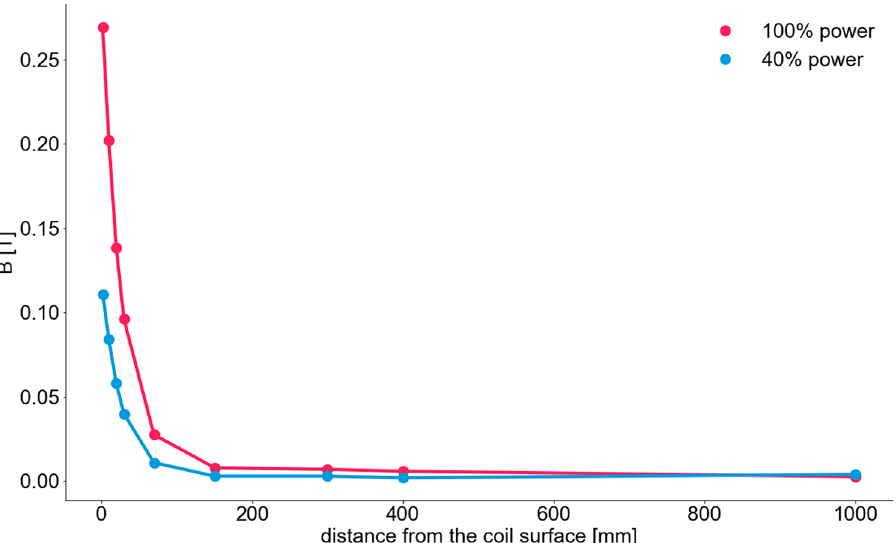
Figure 2. Magnetic flux density at different test points. Measurement of magnetic flux density at different test points in laboratory. Magnetic flux density showed exponential decline with distance from the coil surface. Measurements were done at 100% and 40% power. Points are connected with lines for visual guidance. B magnetic flux density (Tesla).